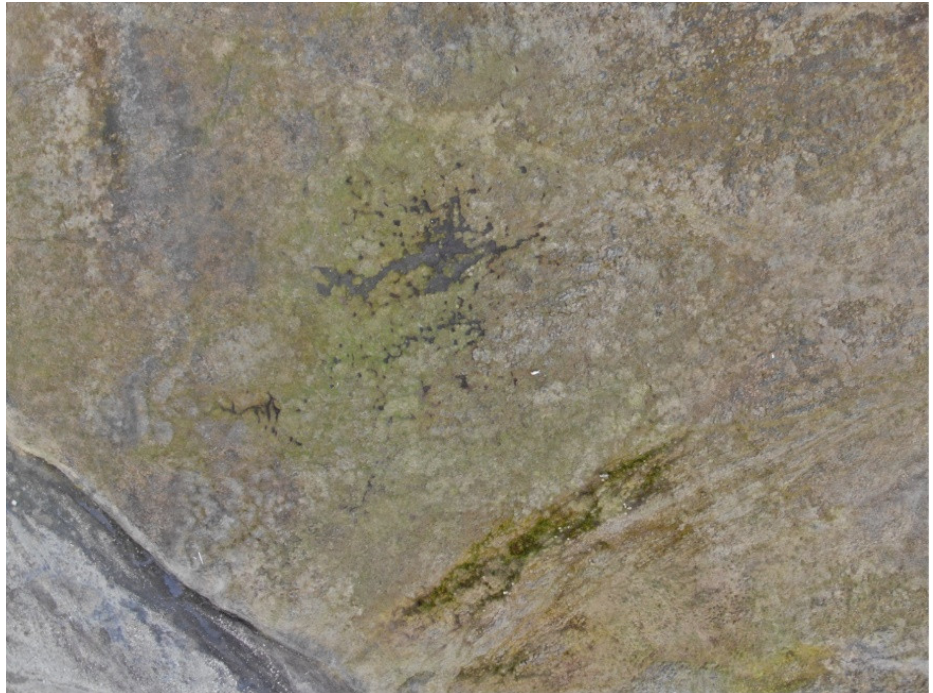
Figure A5. A full-scale image like the one you will see when you go through the images and classify reindeer into one of the five categories in Figure A7. Do you see a reindeer? Try to remember the size of the reindeer relative to the full-scale image. If you see anything that resembles a reindeer, you can zoom in using the buttons on the left.